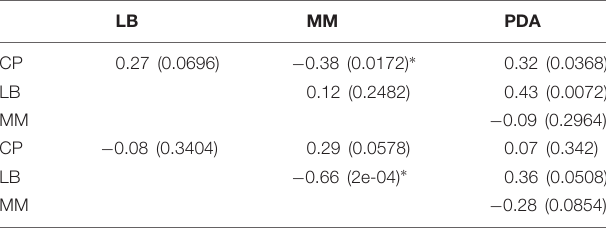
TABLE 3 | Comparison of matrices using Quadratic Assignment